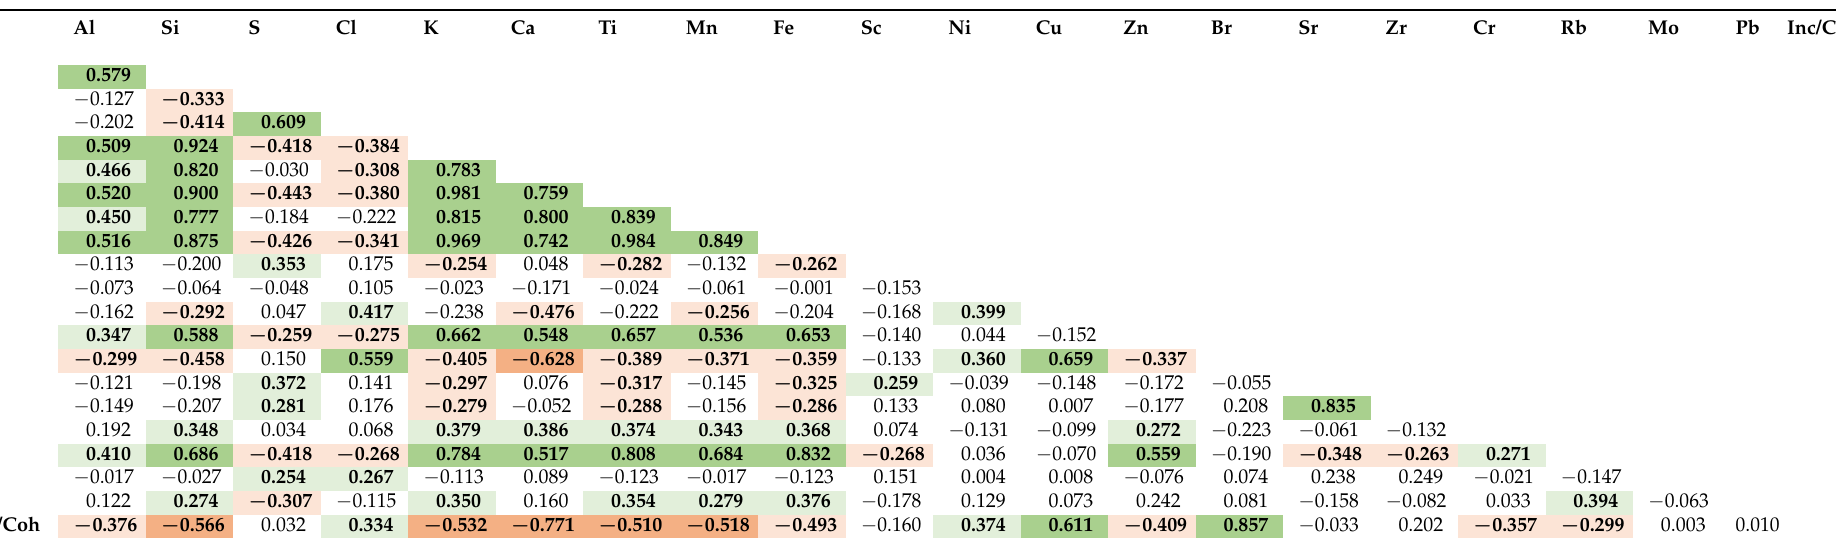
Table 3. Table displaying Pearson correlation coefficients (r) between raw element cps data detected by the XRF scanner from profundal core CHI19-1A. Dark- green-shaded cells are indicative of variables which display a coefficient of r > 0.5, whilst light-green-shaded cells indicate variables with a correlation coefficient for loss on